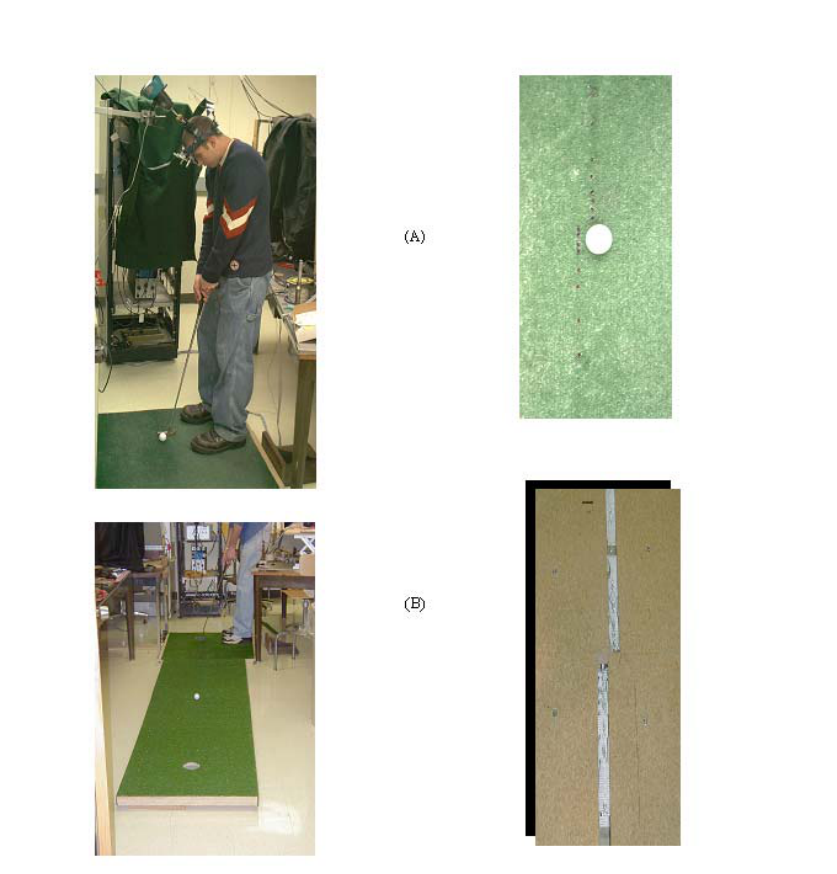
FIGURE 1 . (Left column of figures) Putter platform in use during an experimental trial. (A) Subject wearing helmet (for eye and head movement measurements) and preparing to putt on the first section of the platform. Note that under this section are the embedded photodetector arrays (see Fig. 2). (B) Two other sections are combined with the first section to provide the setup for the 9-ft putts. Turning around the third section (where the hole is) and removing the middle section allows for 3-ft putts. FIGURE 2 . (Right column of figures) Top view of first section of platform where the subject stands (see Fig. 1A) showing ball and photodetector locations. (B) Arrays of photodetectors embedded under the artificial turf in the platform. Note the front array is offset so that the ball movement will not trigger the detectors. The relative position of the golf hole is in front of the photodetectors (i.e., in the direction below the